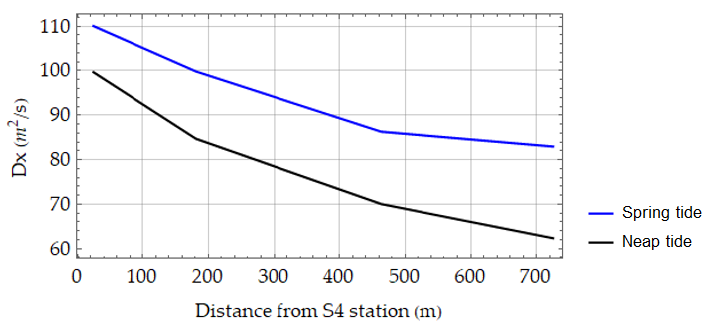
Figure 10. Longitudinal distributions of the dispersion coefficient deduced using the FAT system during spring tide and neap tide.